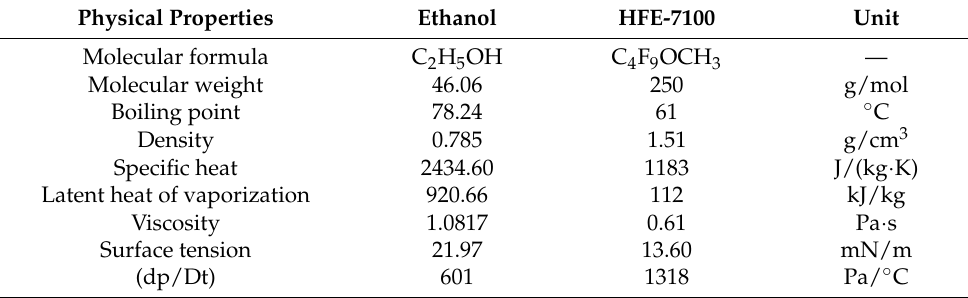
Table 2. Thermophysical parameters of ethanol and HFE-7100 at 25 ◦ C.